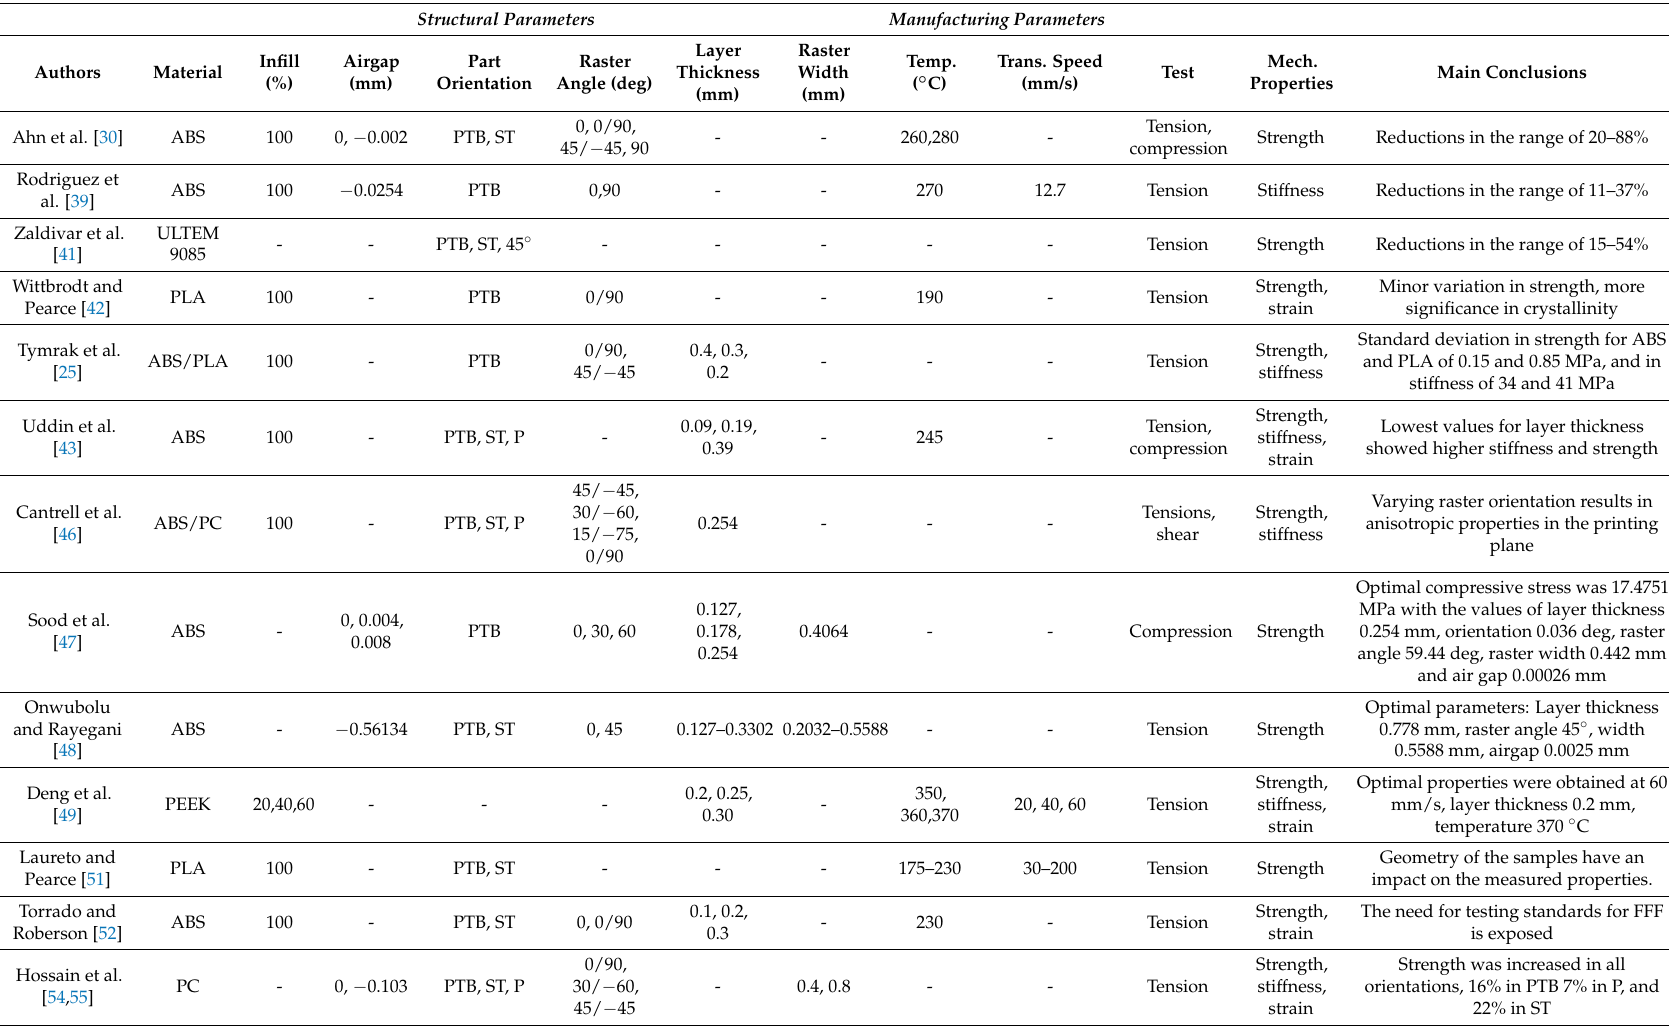
Table 1. Summary of the works for the tensile